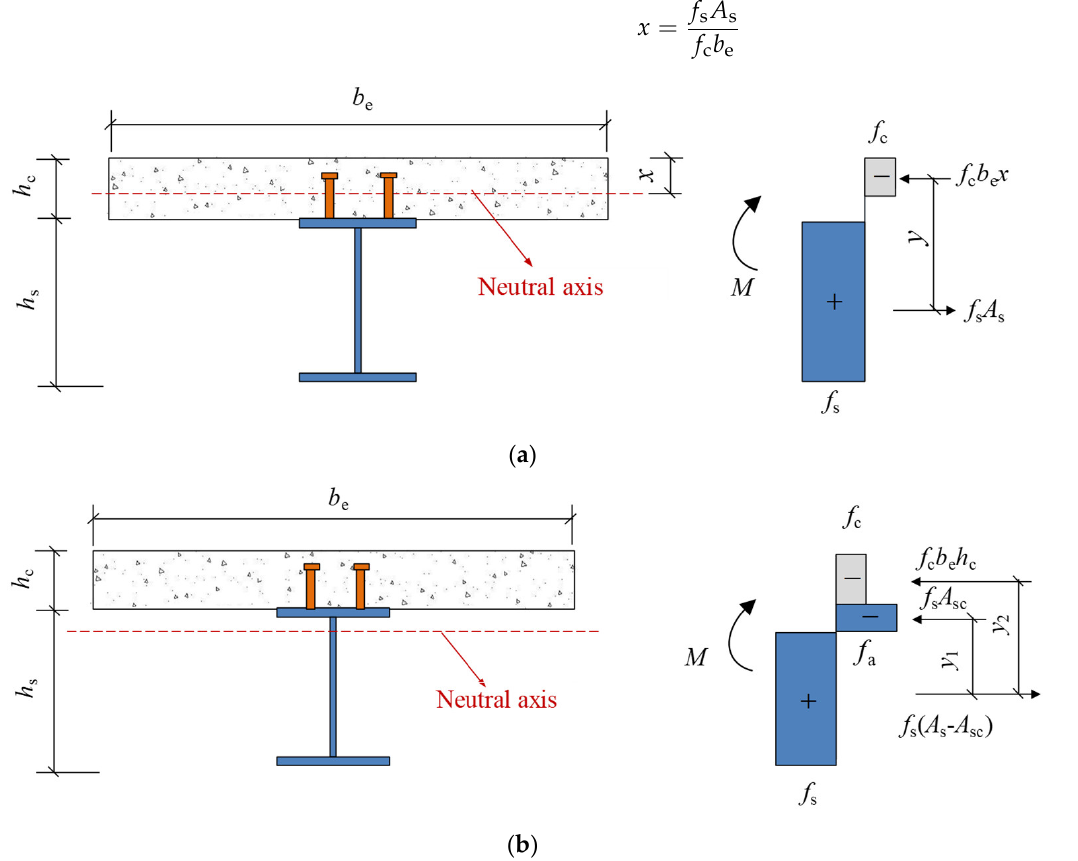
Figure 7. Stress distributions of composite beam section. ( a ) Neutral axis in concrete flange and ( b ) neutral axis in steel member.